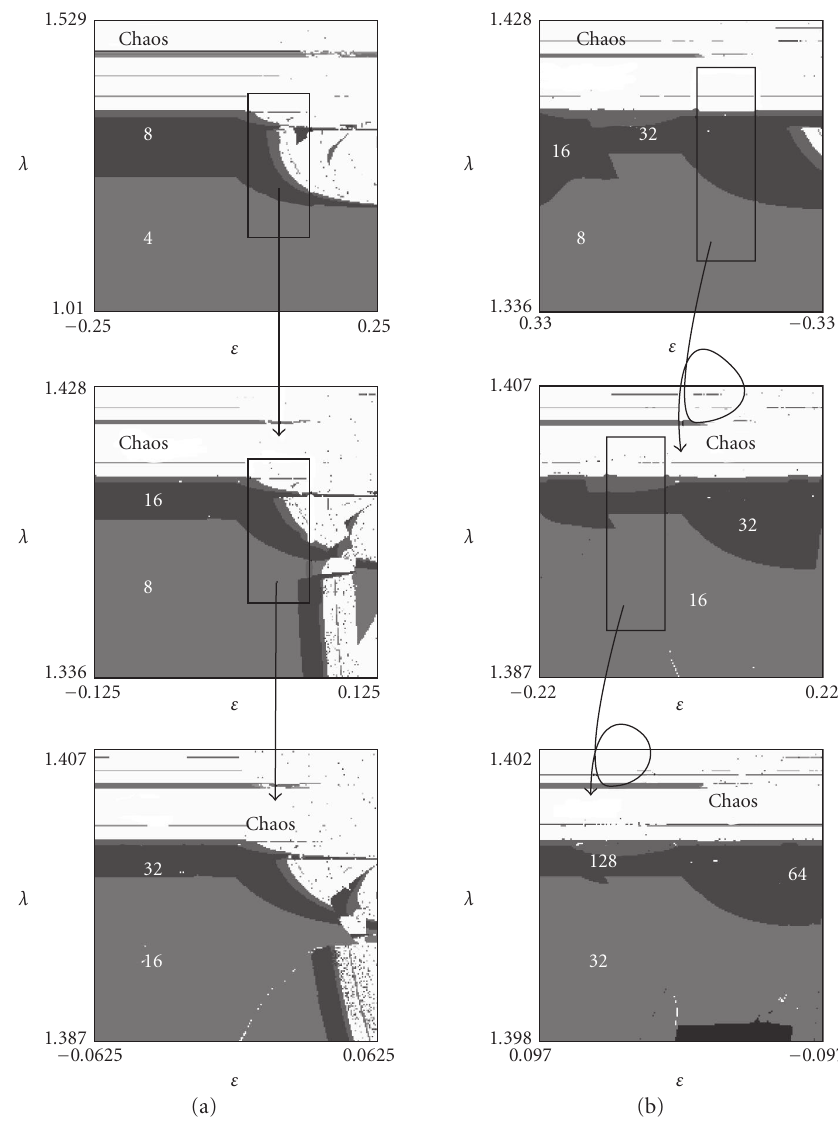
Figure 3.1. Illustrations of a scaling at the parameter space ( λ , ε ) for pure dissipative (left side) and pure inertial (right side) couplings for the following values of the rest parameters A = 1 . 1249, B = 0 . 375, which correspond to the bicritical point and p 1 = 0 . 25. Di ff erent tints of grey colour mean periodic behaviour, white area—chaos. Numbers mean the di ff erent periods of oscillations. One can see that after special rescaling we have a similar structure near the bicritical